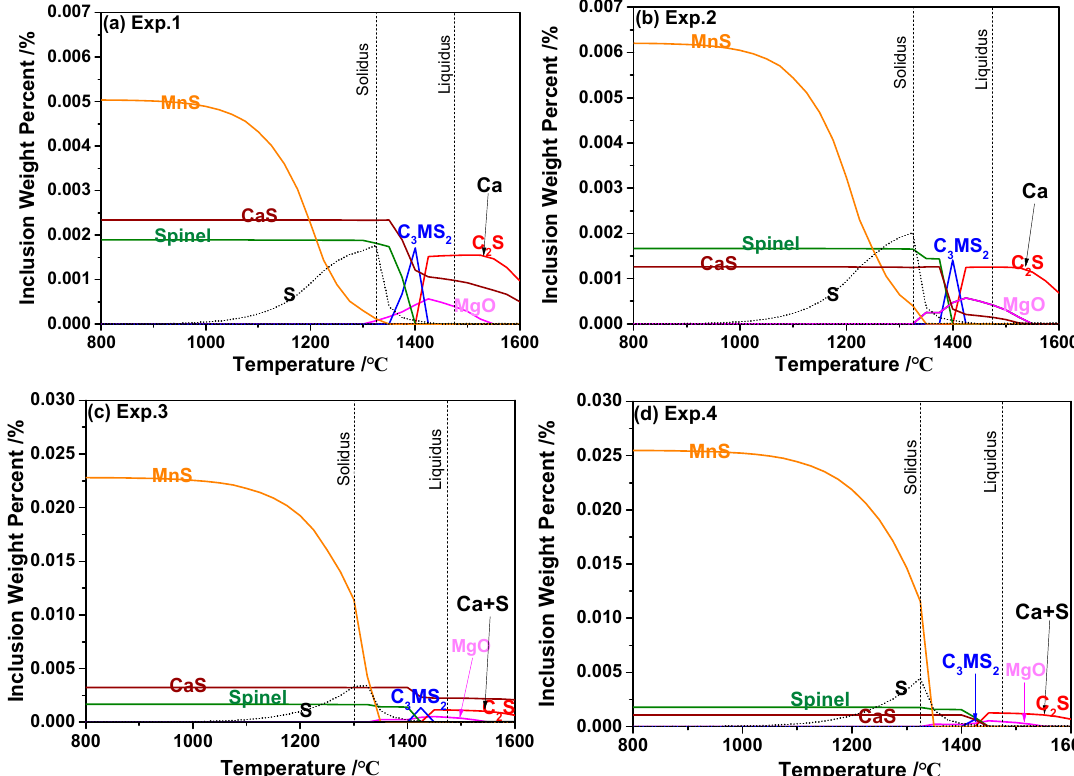
Figure 9. Phase transformation of inclusions and sulfur content in γ -Fe during cooling of 95CrMo steels by FACTSAGE (C 2 S represents 2CaO · SiO 2 ; C 3 MS 2 represents 3CaO · MgO · 2SiO 2 ). ( a ) Experiment 1; ( b ) Experiment 2; ( c ) Experiment 3; ( d ) Experiment 4.